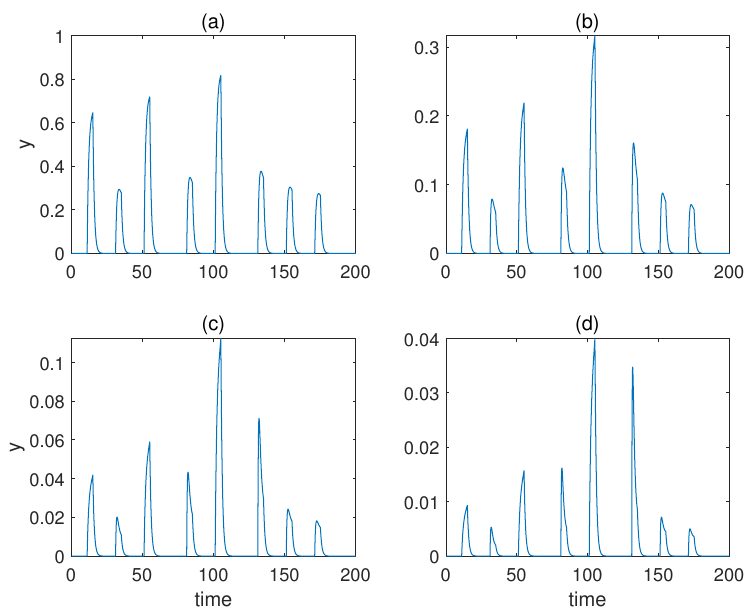
Figure 7. The concentration of molecule y under various Hill coefficients a for the model with forced dissociation. ( a – d ) Results when a = 1,2,3,4. α yx = 2, α yz = 4, α xyz = 4, α ux = 0.6, α vx = 1.5, β u = 0.1, β v = 0.02.